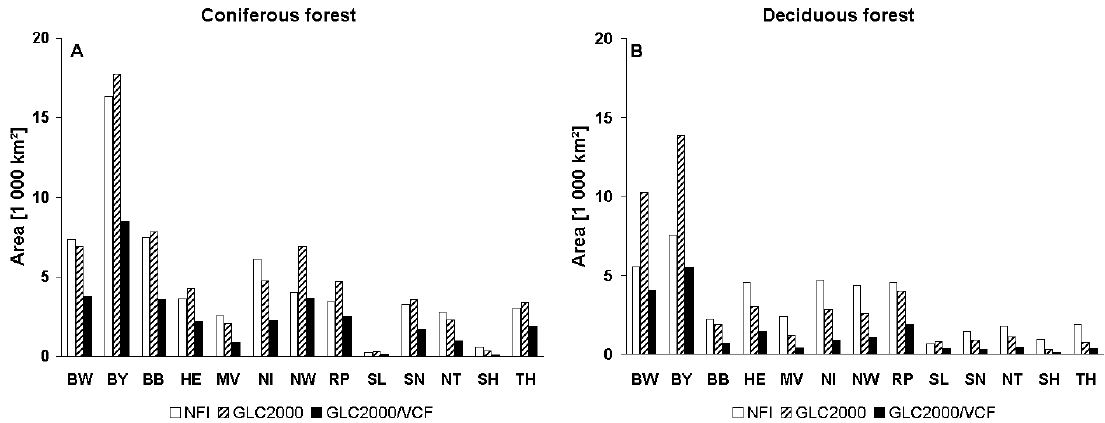
Fig. 5. Comparison of coniferous and deciduous forest areas from NFI, from GLC2000, and from the intersection of GLC2000 and MODIS VCF areas. Areas are given in 1000km 2 per NUTS-1 unit. BW: Baden Wuerttemberg, BY: Bavaria, BB: